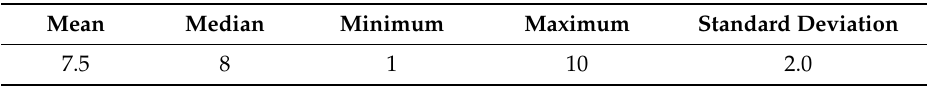
Table 3. Study of the level of intensity of the motivation to participate in the future editions of Poznan Half Marathon.